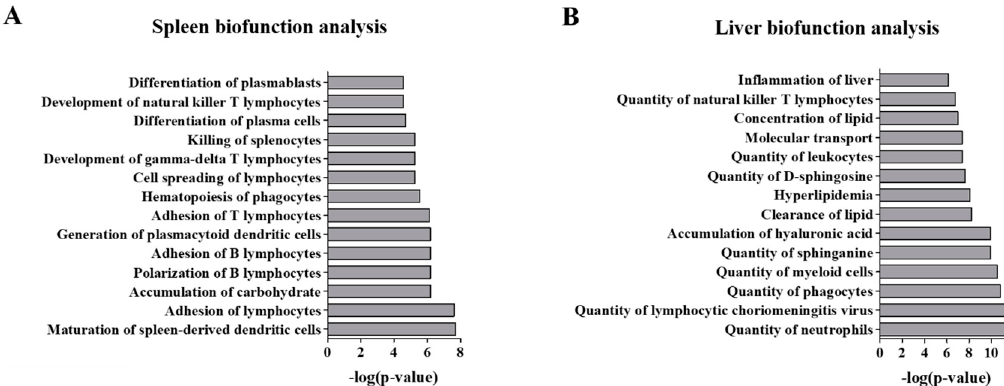
Figure 3. Functional analysis of the differential proteome of the spleen and liver of 11-week Npc1 − / − mice. Differential proteins from the mass spectrometry analysis of the spleen ( A ) and liver ( B ) of Npc1 − / − mice where enriched for top biological functions. Significance was determined using a Right-tailed Fisher’s exact test to determine probability of pathways from the Ingenuity Pathway Analysis Knowledge Base Library to those most significantly enriched.